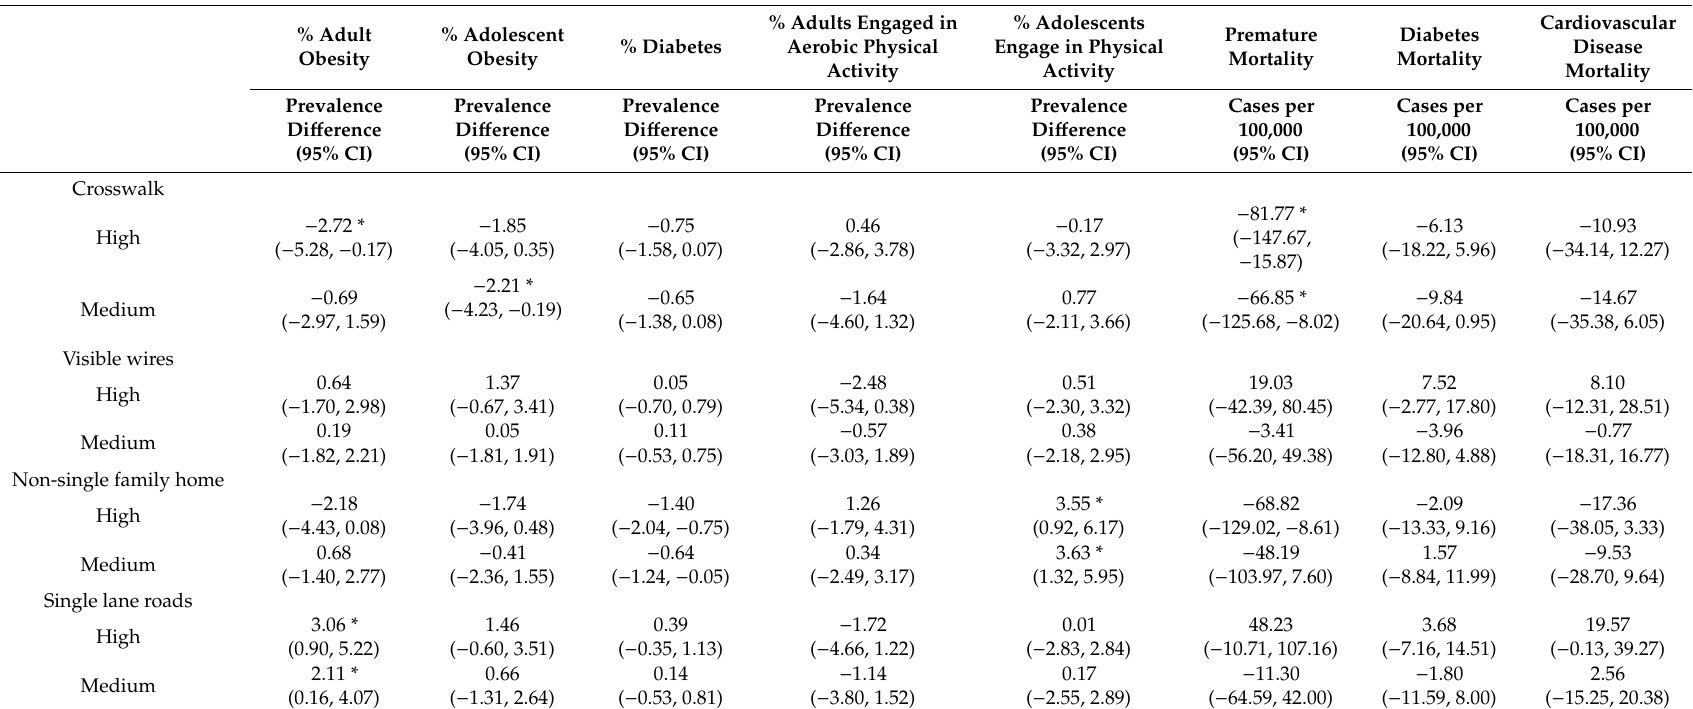
Table 2. Associations between state health outcomes and built environment characteristics